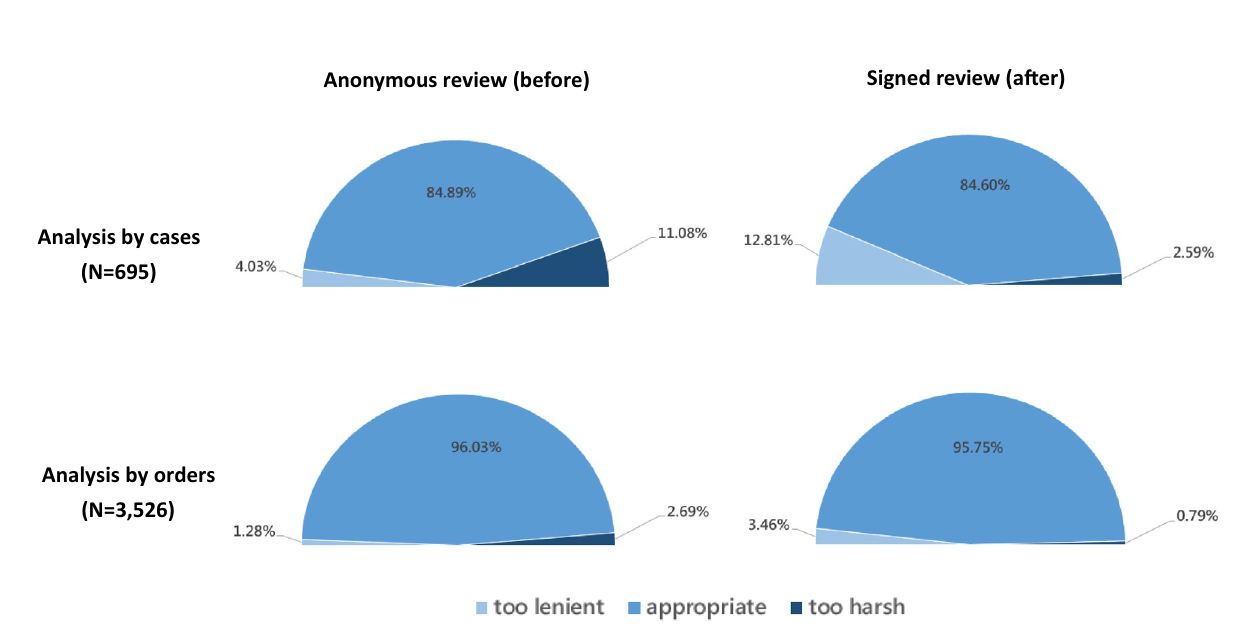
Table 4. Appropriateness assessment of the review decision under the Taiwanese National Health Insurance scheme. * P < 0.05, ** P < 0.01, *** P < 0.001 when comparing the percentages of “too lenient” and “too harsh” between 2016 and 2017.